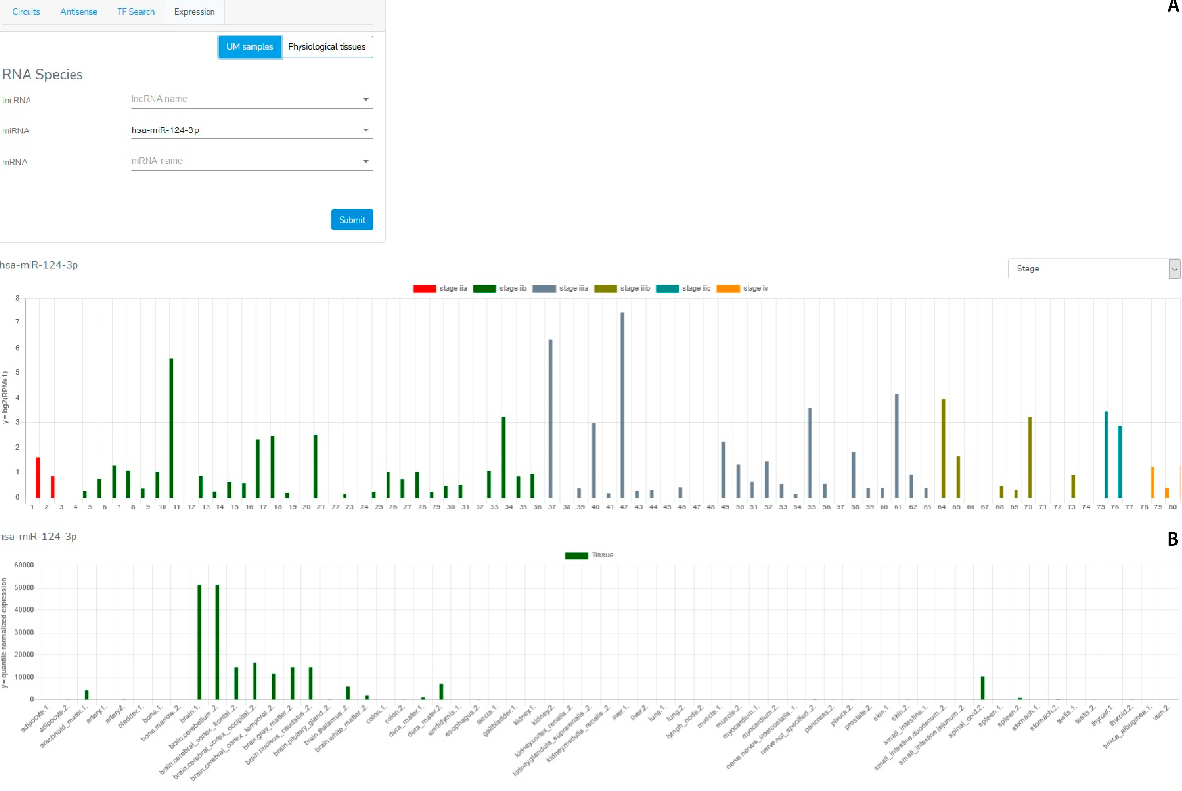
Figure 6. Results section of the VECTOR database for the “Expression” query. ( A ) The expression of the selected RNA molecule in UM samples from TCGA is shown as histograms. The color of the histogram allows to classify each sample according to the selected clinicopathological parameter. ( B ) The expression of the selected RNA molecule in a set of physiological tissues is shown as histograms.